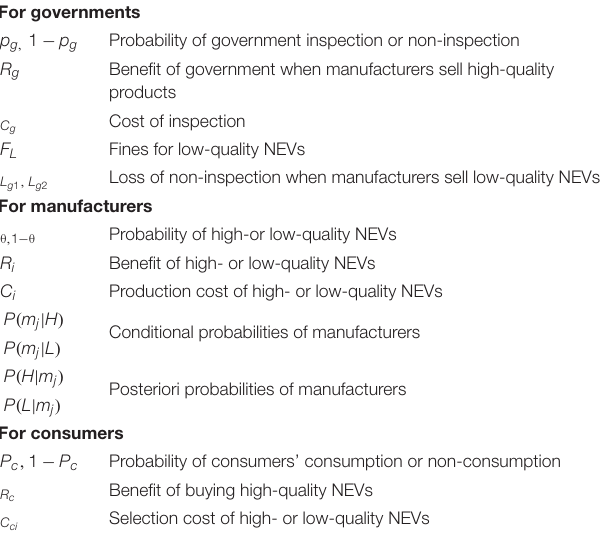
TABLE 2 | Parameters and